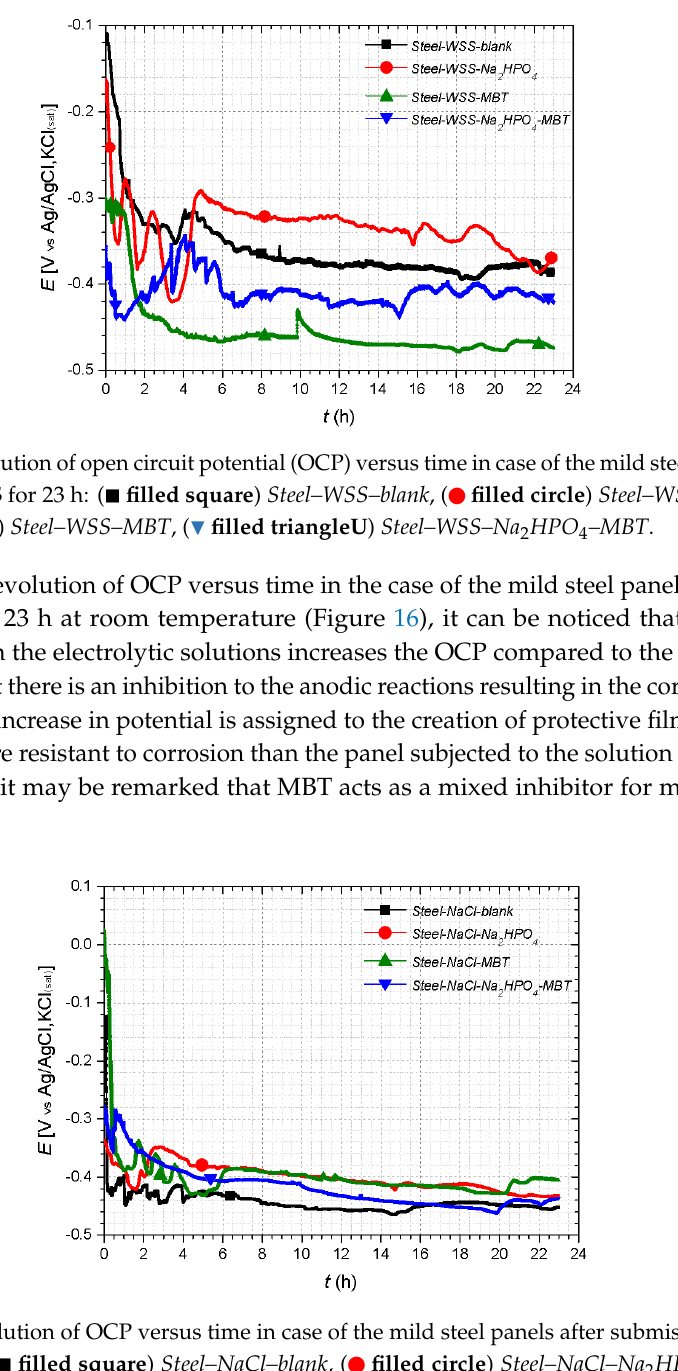
Figure 16. The evolution of OCP versus time in case of the mild steel panels after submission in 3.5 wt % NaCl for 23 h: (  filled square ) Steel–NaCl–blank , (  filled circle ) Steel–NaCl–Na 2 HPO 4 , (  filled triangleD ) Steel–NaCl–MBT , ( ▼ filled triangleU ) Steel–NaCl–Na 2 HPO 4 –MBT